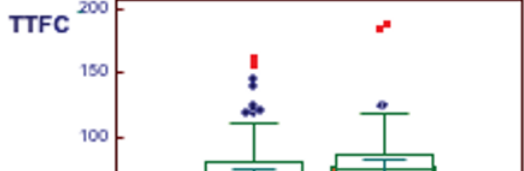
Figure 4. New index TTFC in diabetic patients and non